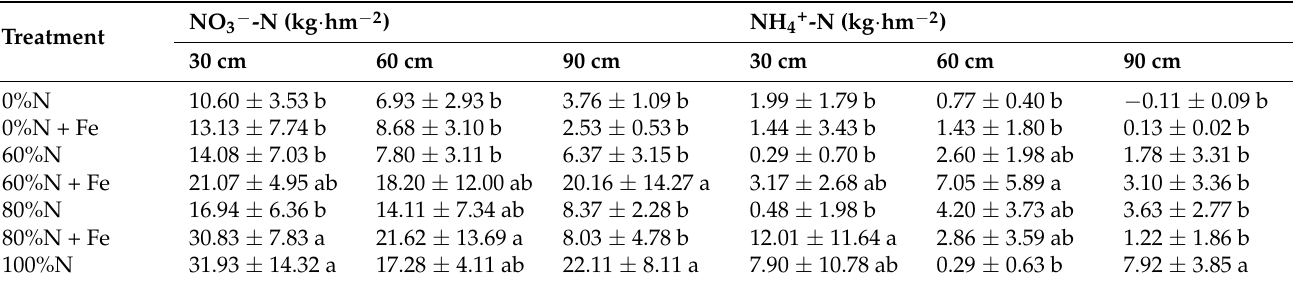
Table 4. Ammonium and nitrate leaching from a paddy field at a soil depth of 30, 60, and 90 cm under various nitrogen fertilization rates with or without iron amendment in